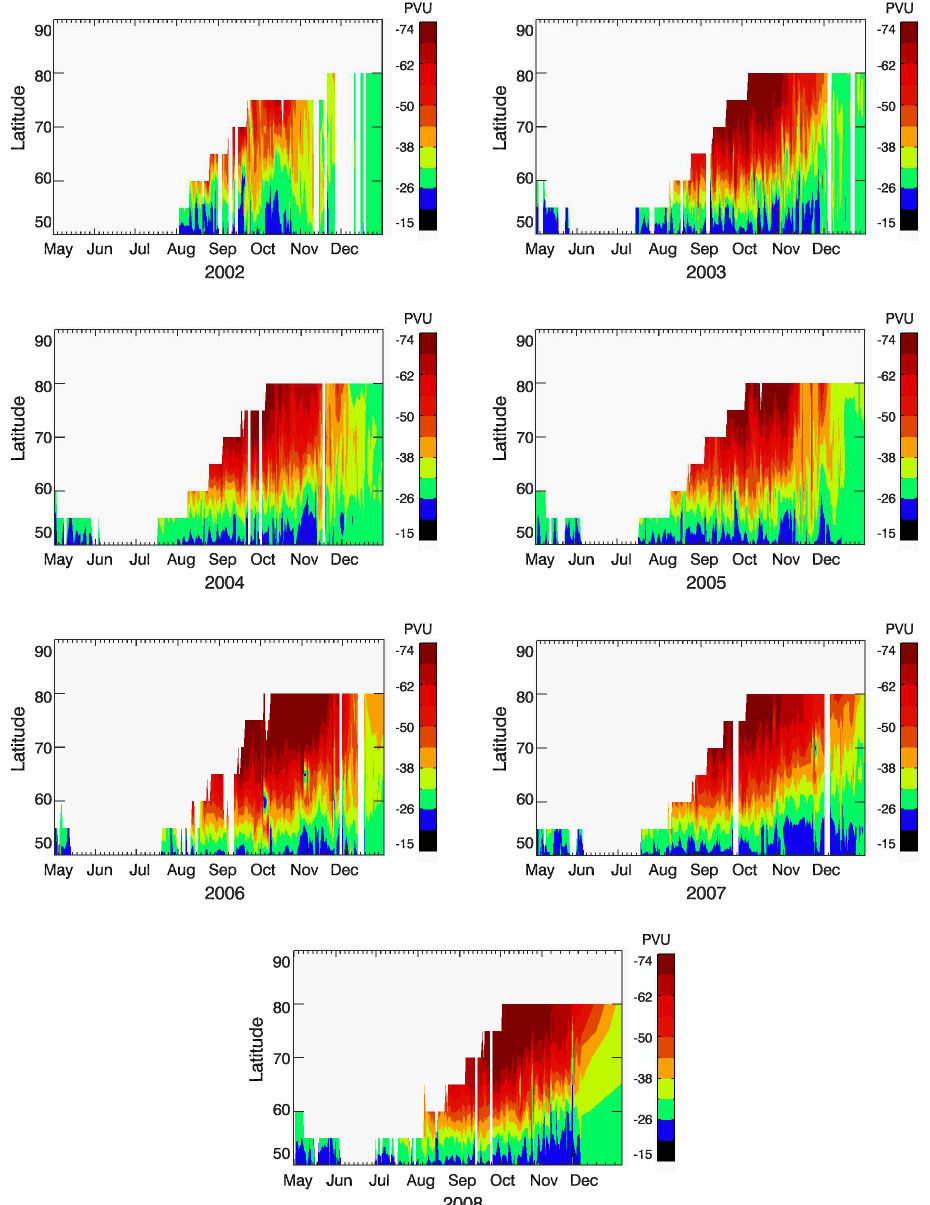
Fig. 3. Daily and zonally averaged modified potential vorticity at the 475K isentropic level in the Antarctic stratosphere for the latitudes of SCIAMACHY observations in 2002–2008 during winter/spring.